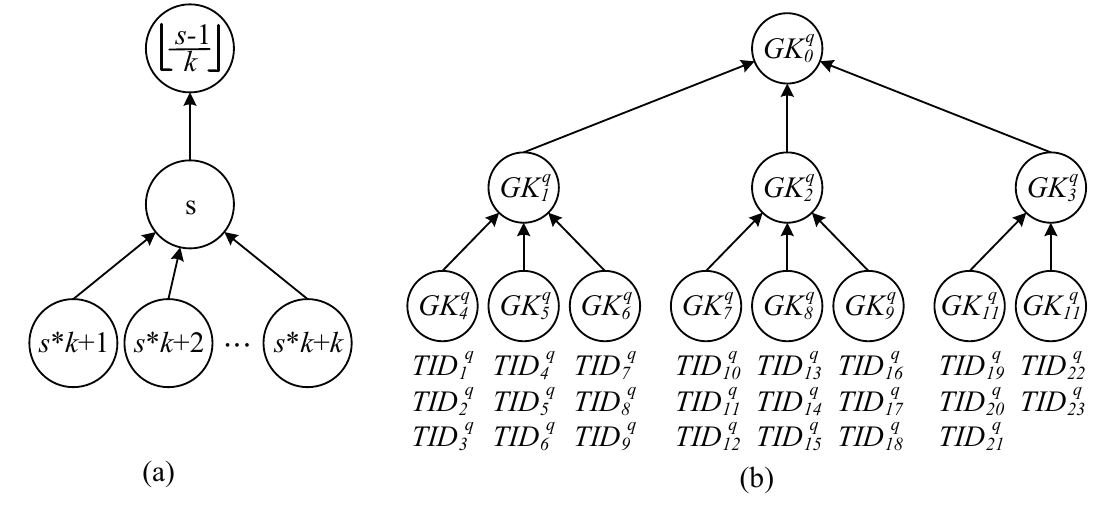
Figure 2. Group Key tree of cargo tags of recipient (cid:1842) (cid:3044) : ( a ) Rule for numbering among group keys; ( b ) key tree for 3-ary group